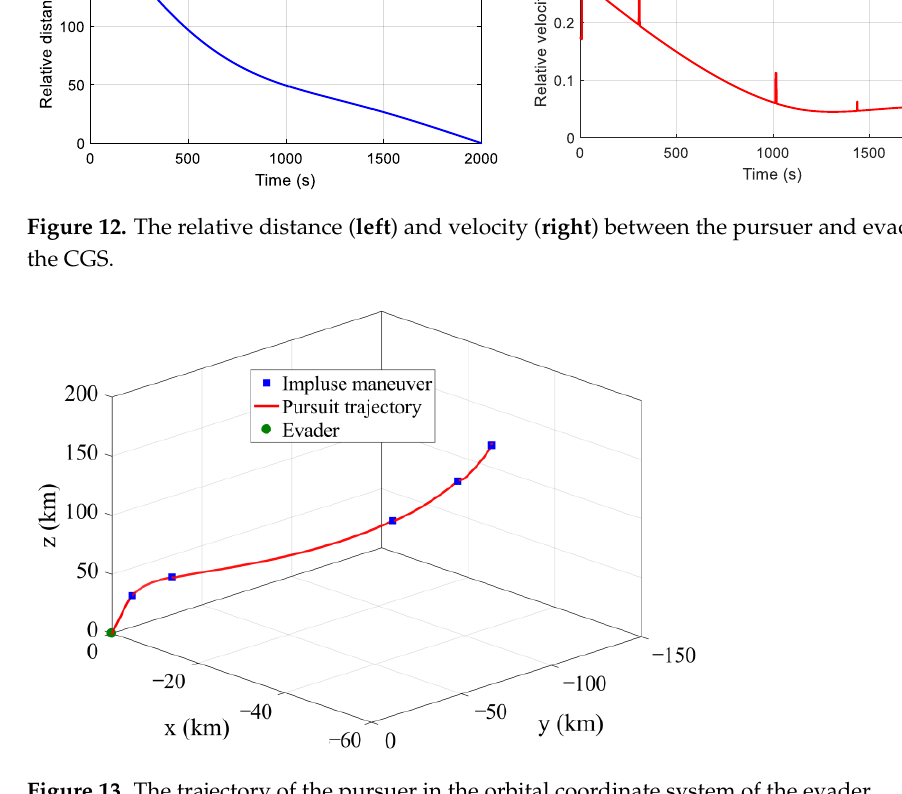
Figure 13. The trajectory of the pursuer in the orbital coordinate system of the evader.